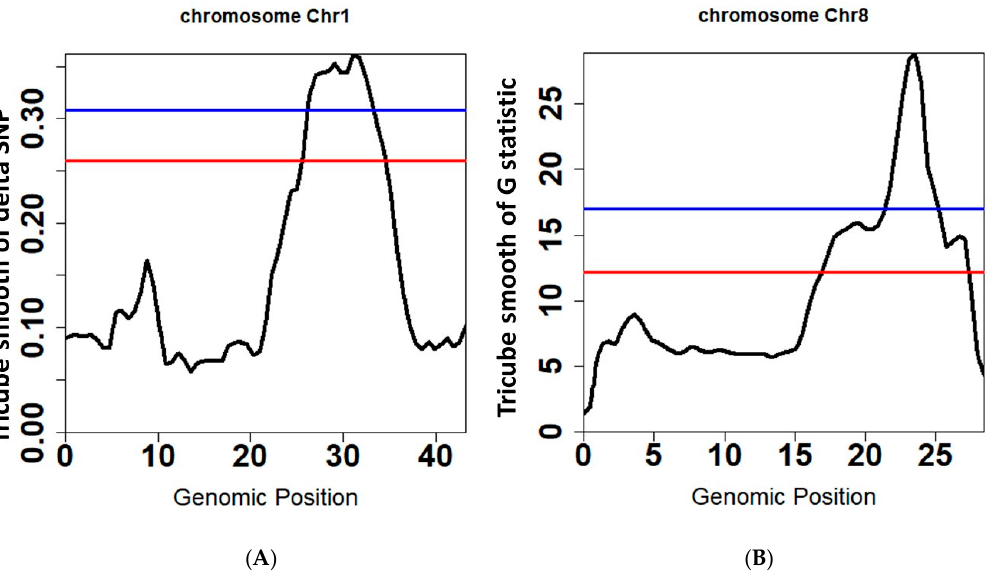
Figure 5. QTLs for rice seedling cold tolerance on chromosomes 1 and 8 identified by ∆ SNP and G-test in PNGseqR plots drawn by the “plot_BSA()” function, and statistics are tricube-smoothed with a 5 Mb sliding window. ( A ) The line plot drawn by using the ∆ SNP algorithm. ( B ) The line plot drawn by using the G-test algorithm. The red line is the threshold set by the >85% quantile and the blue line is the threshold set by p -values < 0.05. Table 3. QTLs for cold tolerance at the seedling stage in rice identified by different algorithms in PNGseqR. Chrom a